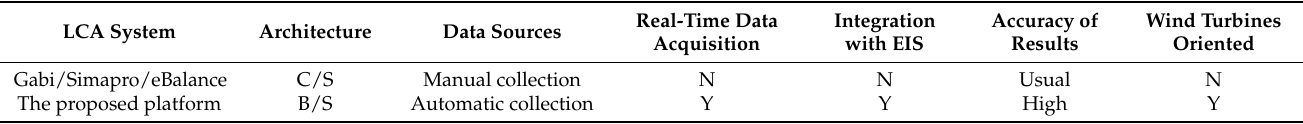
Table 6. Comparison of several LCA